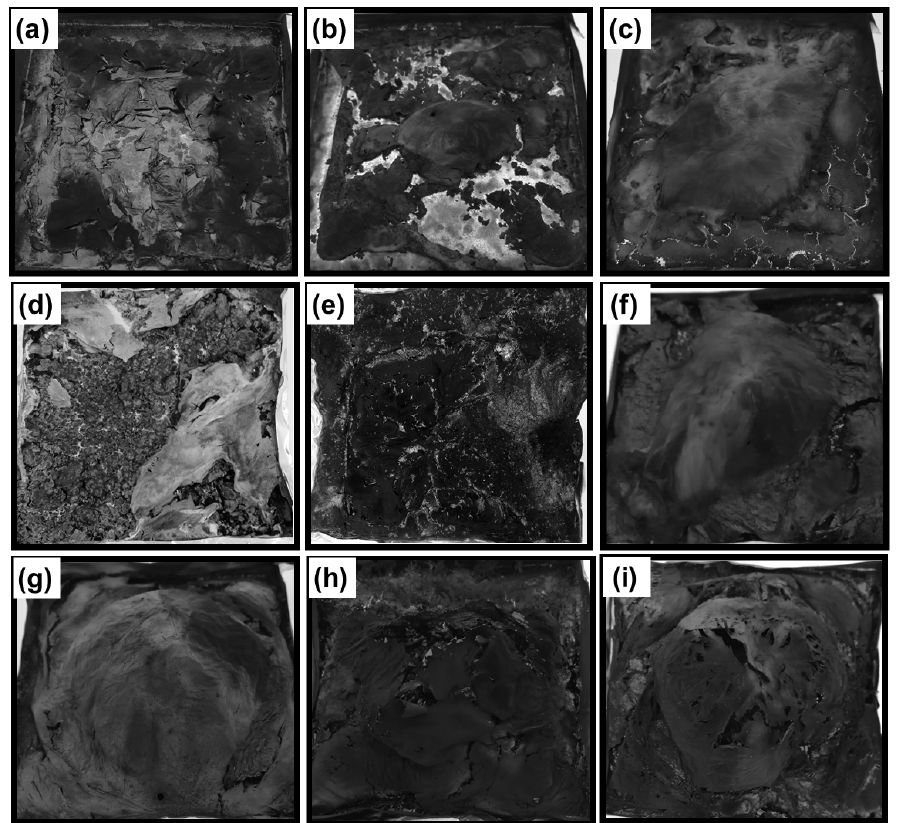
Figure 10. Pictures of char residues collected at the end of cone calorimetry test: ( a ) unfilled polyamide 11 (PA11); ( b ) PA 80 –ZnP 20 ; ( c ) PA 80 –AlP 20 ; ( d ) PA 80 –LL 20 ; ( e ) PA 80 –DL 20 ; ( f ) PA 80 –LL 10 –AlP 10 ; ( g ) PA 80 –LL 10 –ZnP 10 ; ( h ) PA 80 –DL 10 –AlP 10 and ( i ) PA 80 –DL 10 –ZnP 10